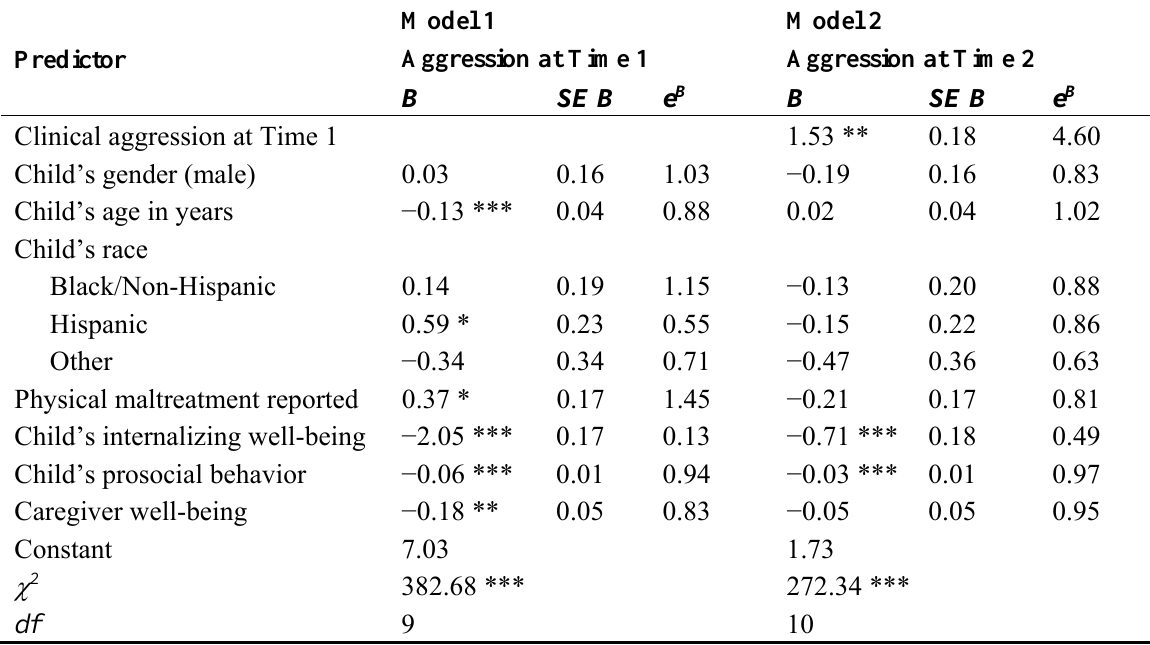
Table 2. Summary of logistic regression analysis for variables predicting children’s clinical level of aggression (n =